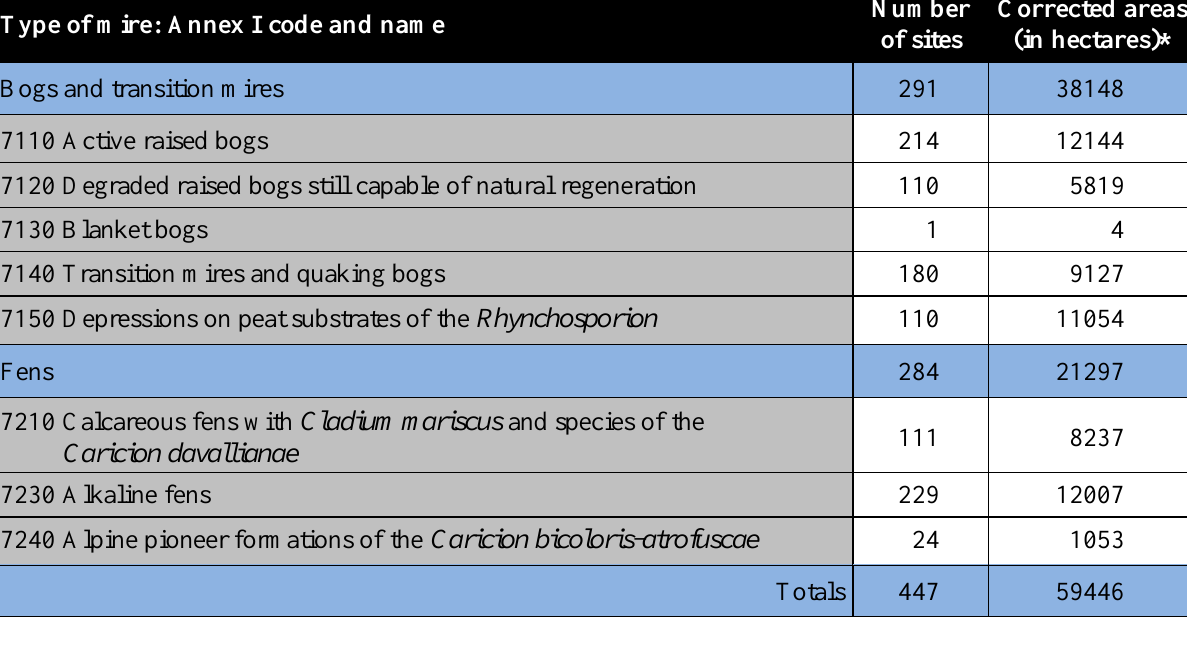
Table 1. Numbers of sites and areas of mires and fens in France corresponding to habitats listed in Annex I of the European Habitats Directive (National Museum of Natural History (MNHN) personal communication 2016, with a caveat that total areas may be